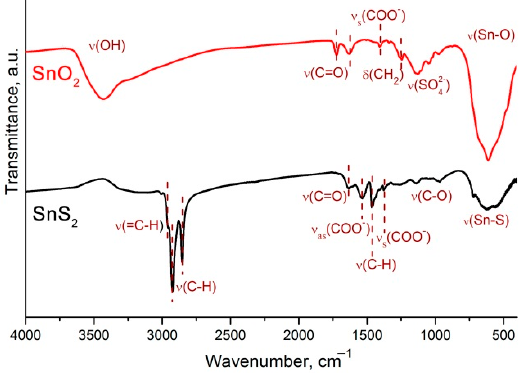
Figure 8. FTIR spectra of SnS 2 and 2D SnO 2 samples.